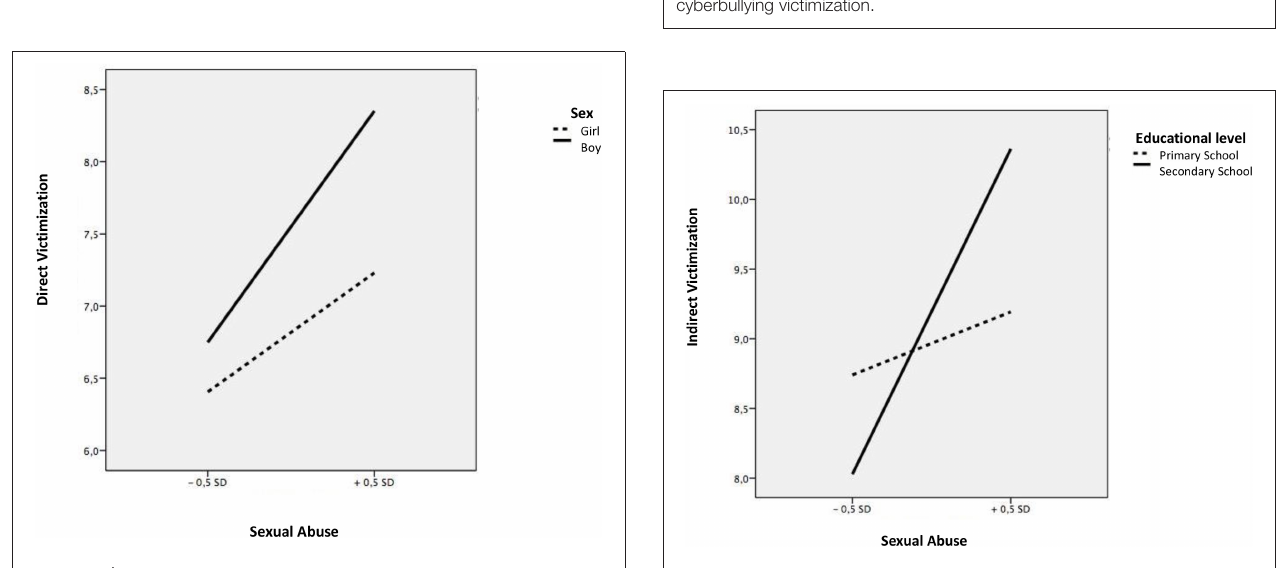
FIGURE 2 | interaction between sexual abuse and sex in relation to direct victimization.